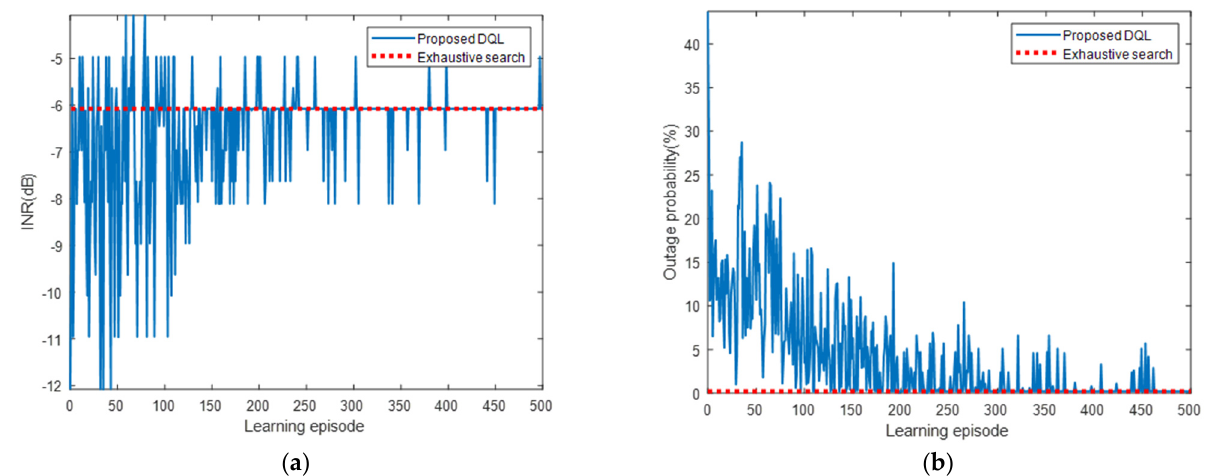
Figure 13. ( a ) 𝐼𝑁𝑅 and ( b ) 𝑝 (cid:3042)(cid:3048)(cid:3047) for each learning episode for interfered receiver ② . Figure 13. ( a ) INR and ( b ) p out for each learning episode for interfered receiver 2 (cid:13)